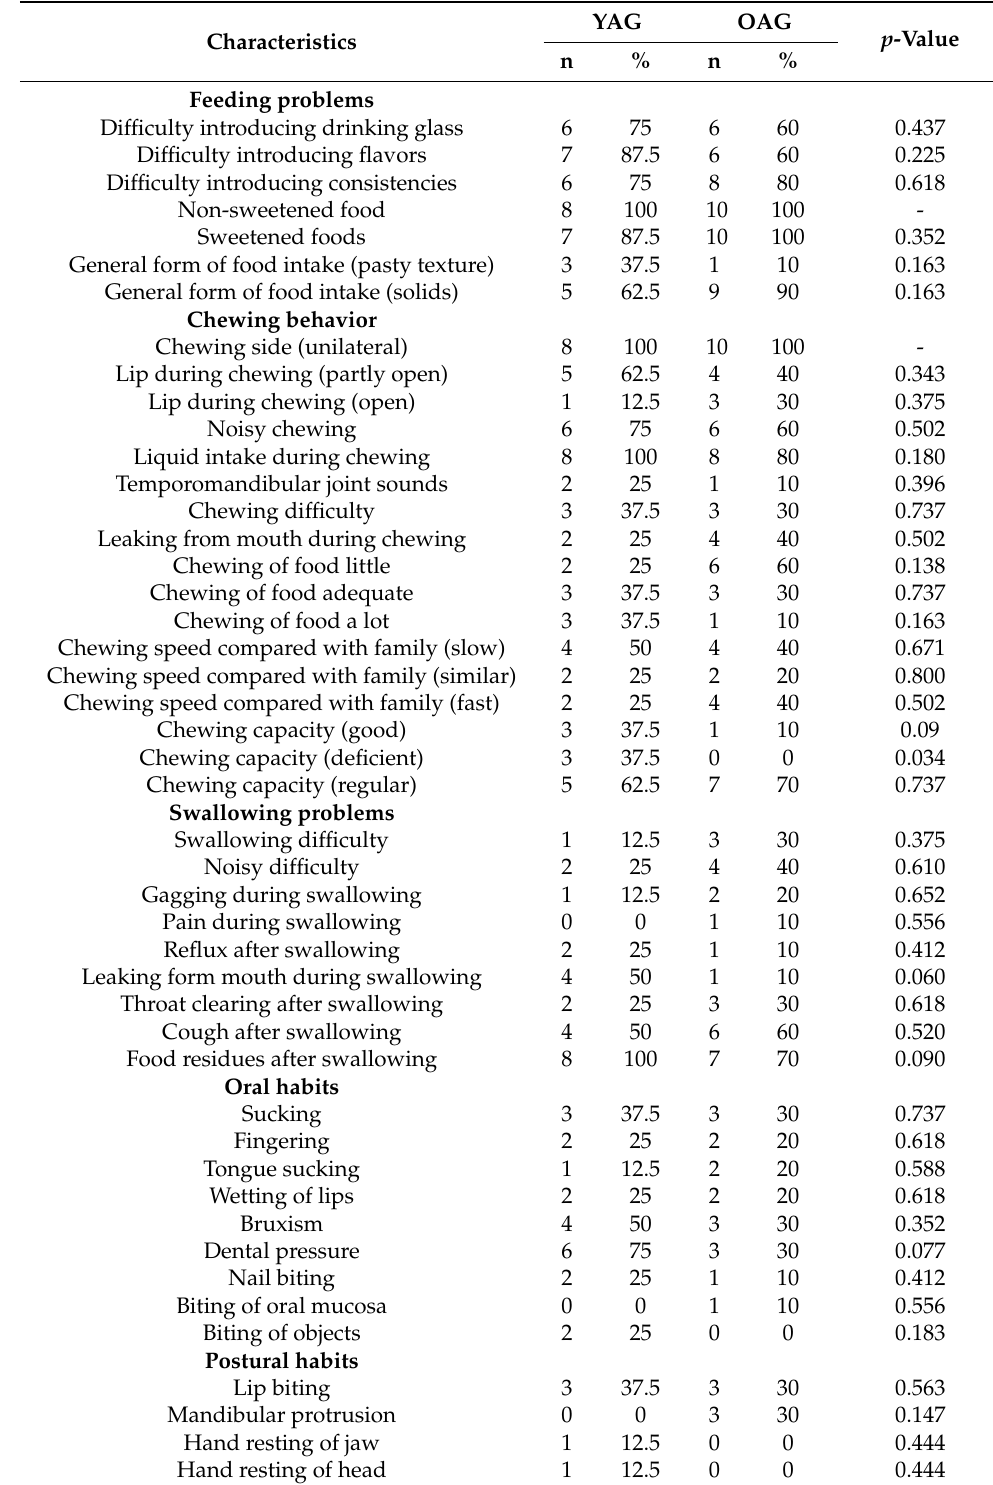
Table 3. Feeding problems, chewing behavior, swallowing problems and oral habits in adults with Down